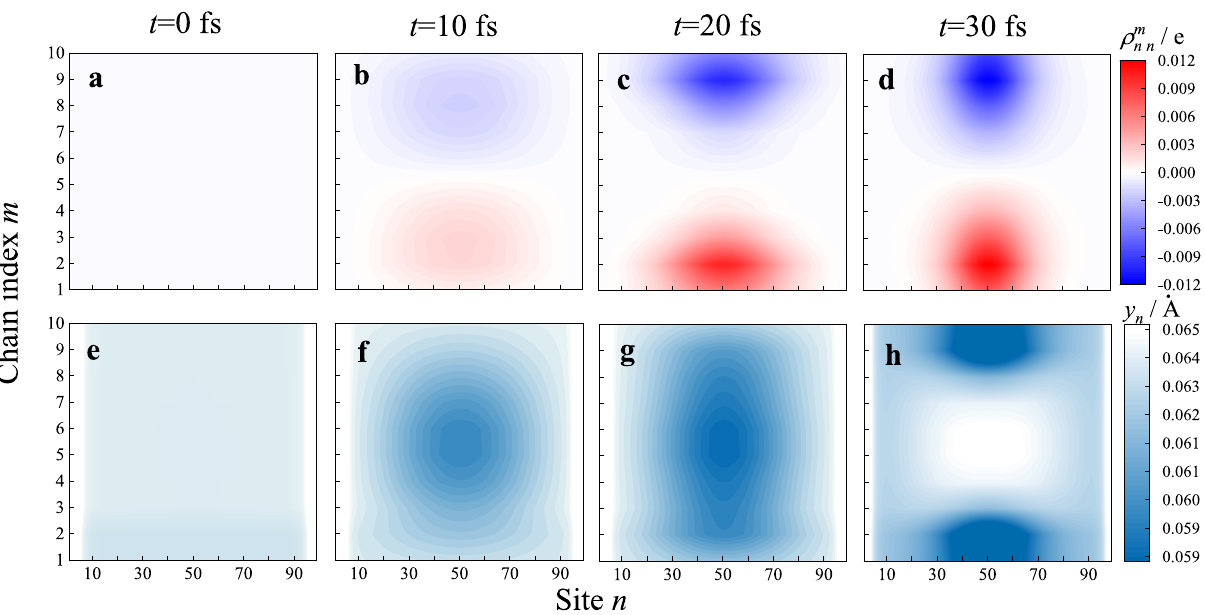
Figure 2. The evolution of charge density and lattice distortion in polymer